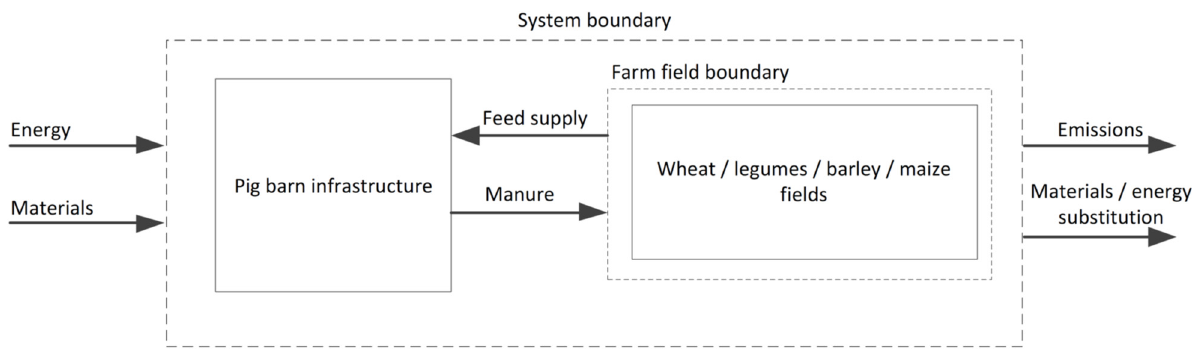
Figure 1. Schematic diagram of the analysed farm system.